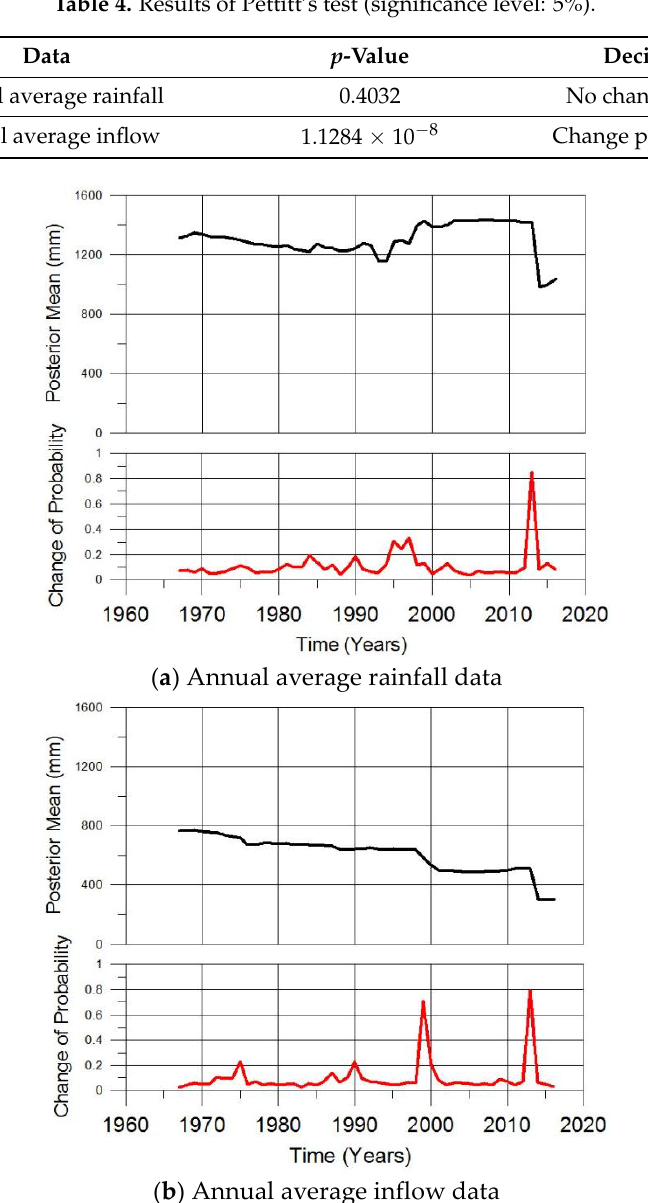
Figure 5. Results of Bayesian change-point analysis.